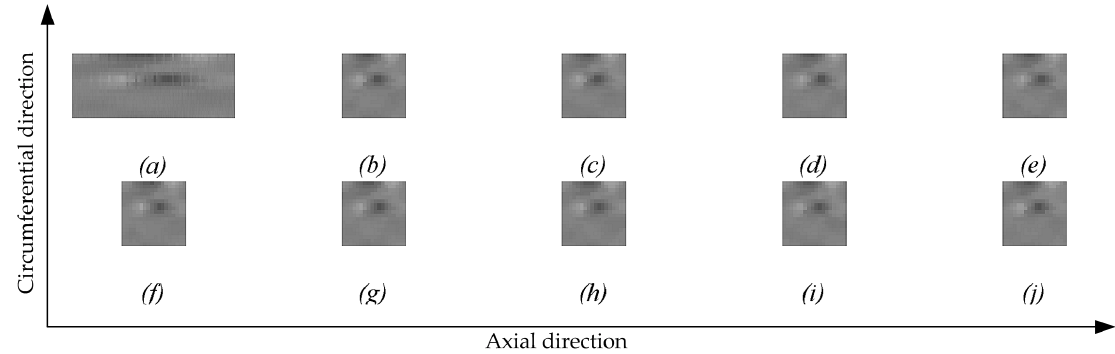
Figure 11. Primary resolution image and low-resolution images: ( a ) primary resolution; ( b – j ) down-sampling images.